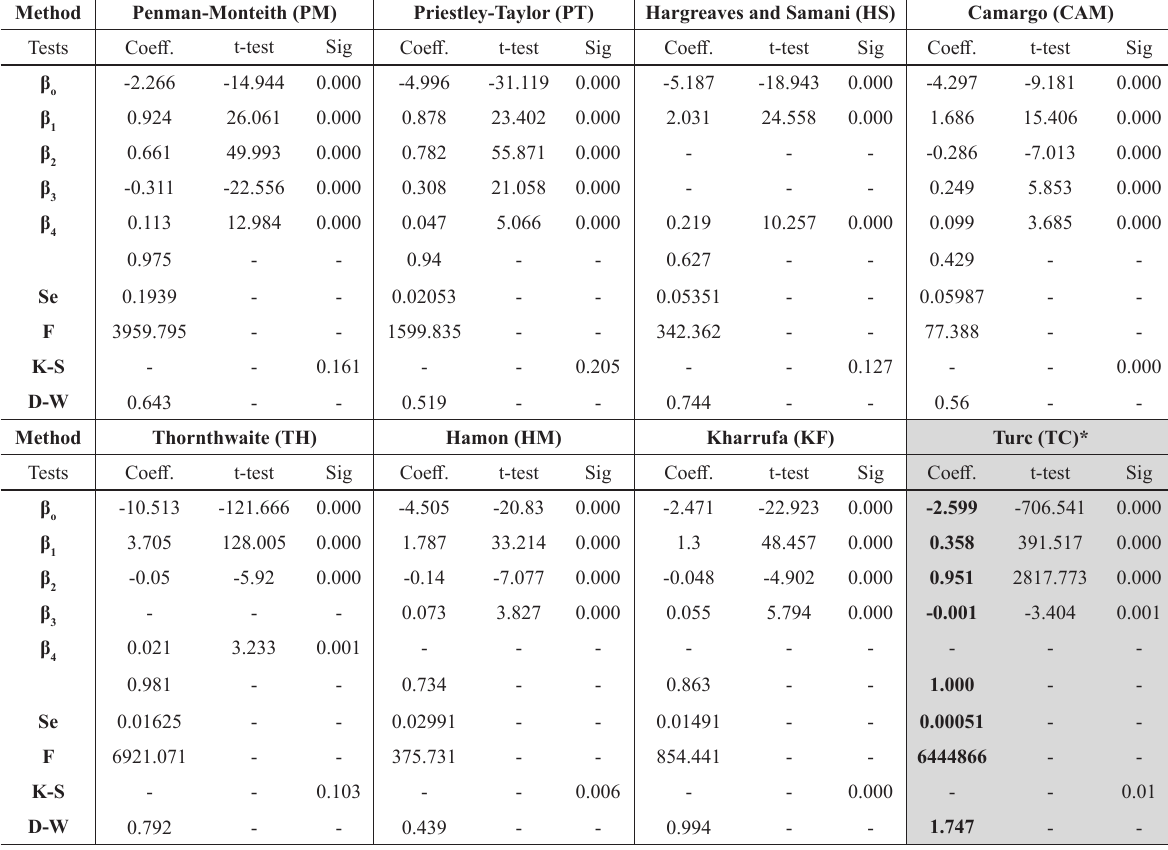
Summary of the estimates and statistical tests of the ETo models for the IRW (N =